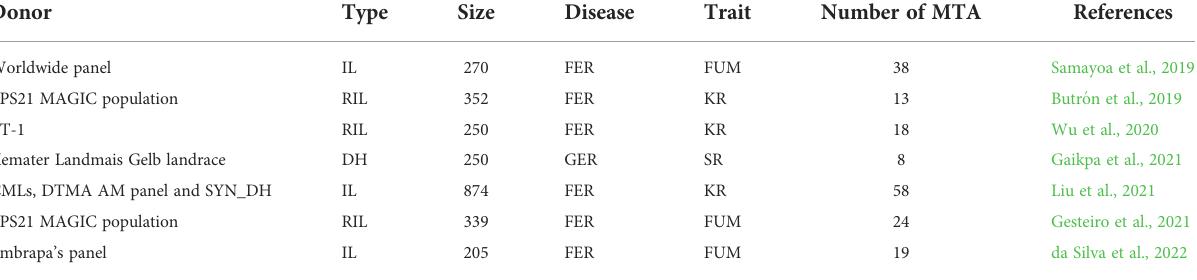
TABLE 5 Characteristics of association mapping studies on resistance to Fusarium (FER) and Gibberella ear rot (GER) used in this study for validation.